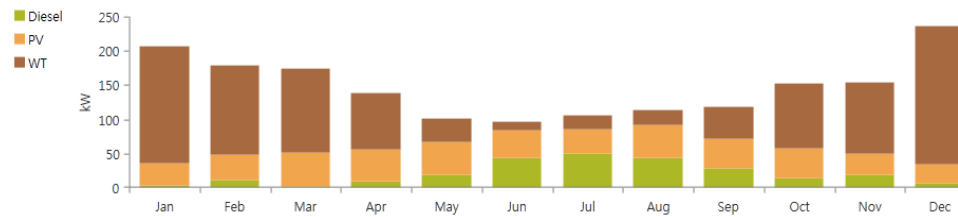
Figure 2. Expected monthly energy production by generator of the test